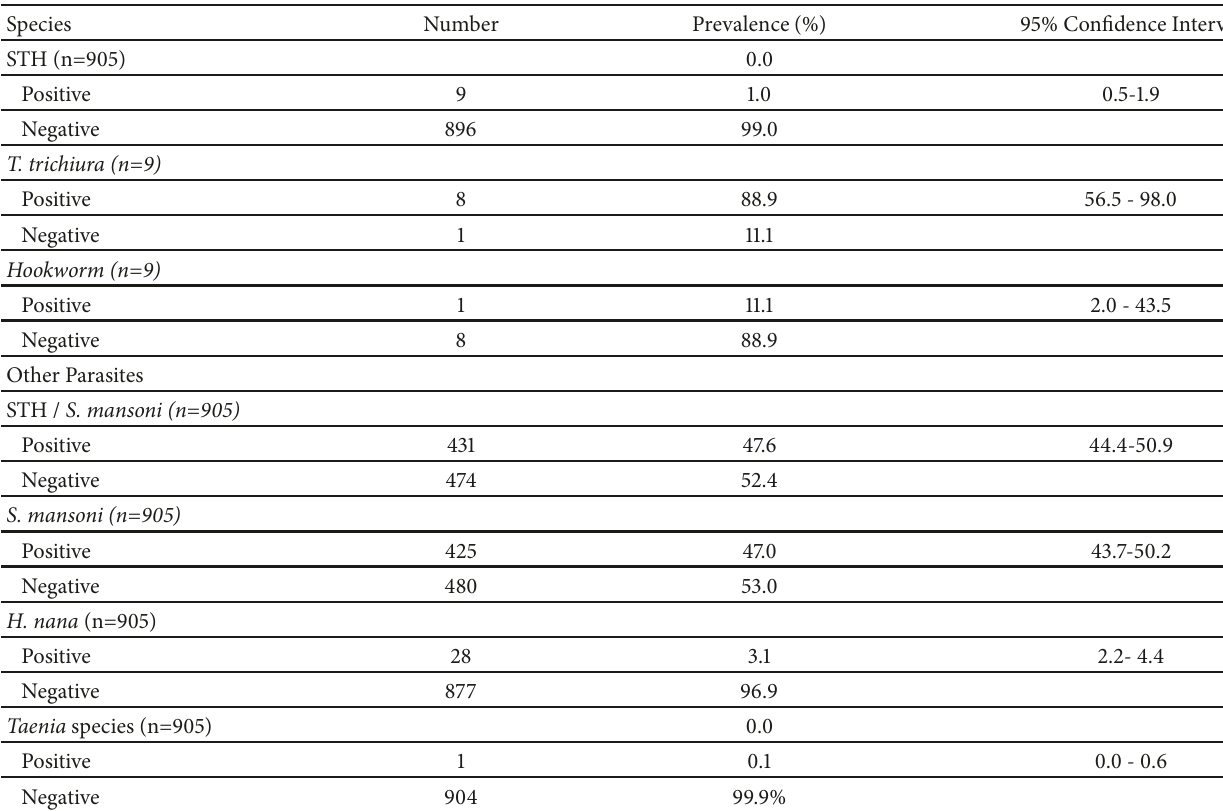
Table 3: Prevalence of STH and other helminths at the household